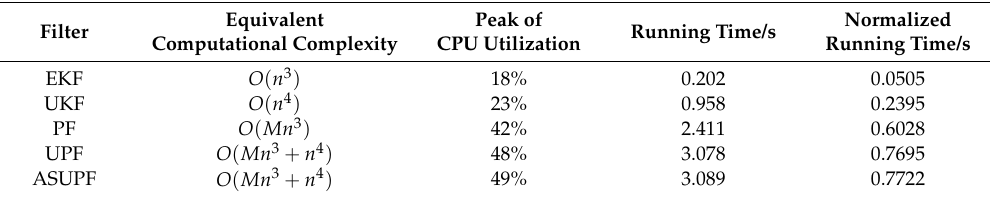
Table 4. Computational performances of EKF, UKF, PF, UPF and ASUPF.